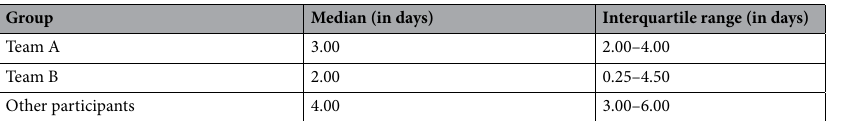
Table 1. Appearance of COVID-19-symptoms after the sport event. A Kruskal–Wallis-Test did not indicate any significant difference between the